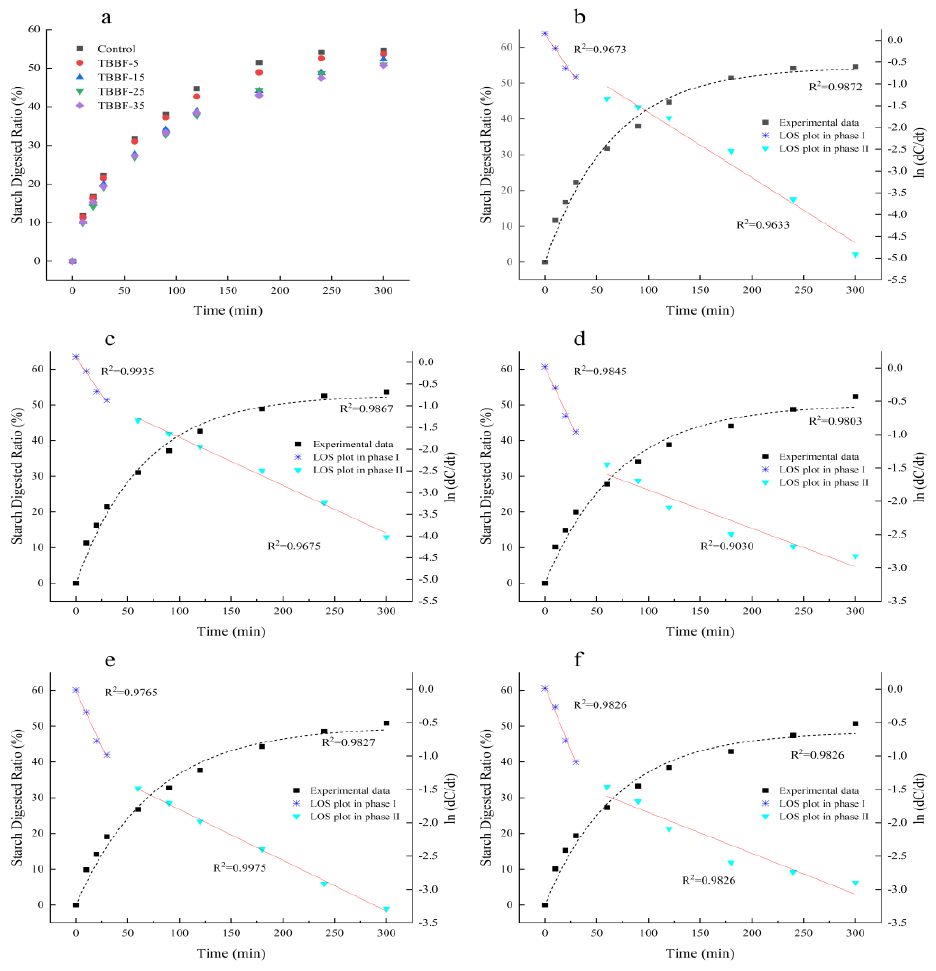
Figure 1. Digestograms for Tartary buckwheat dried noodles with different substitutions of Tartary buckwheat bran flour ( a ); ( b – f ) represent the LOS fitting digestion curves, which were substituted by Tartary buckwheat bran flour at the level of 0, 5%, 15%, 25%, and 35%. The LOS plots in phase I are characterized by blue, and phase II is characterized by bright green. The black squares and dotted line represent the overall digestion data and model-fit curves. R 2 represents the coincidence between the experimental data and the model-fit curves. Table 4. Effect of TBBF substitution on the digestibility of TBDNs.